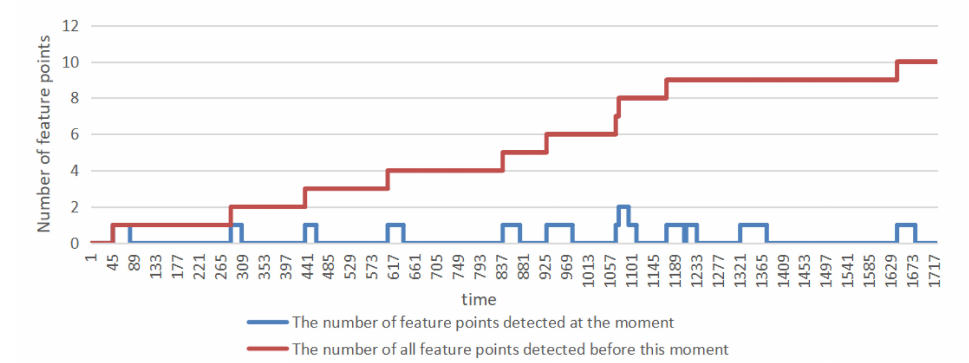
Figure 14. Estimation of the number of feature points. (The sensor route is a serpentine curve. The number of feature points is 10).